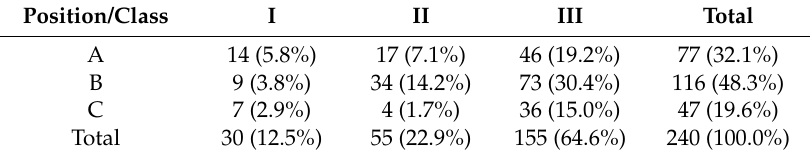
Table 2. Pell and Gregory classification of the associated mandibular third molars.